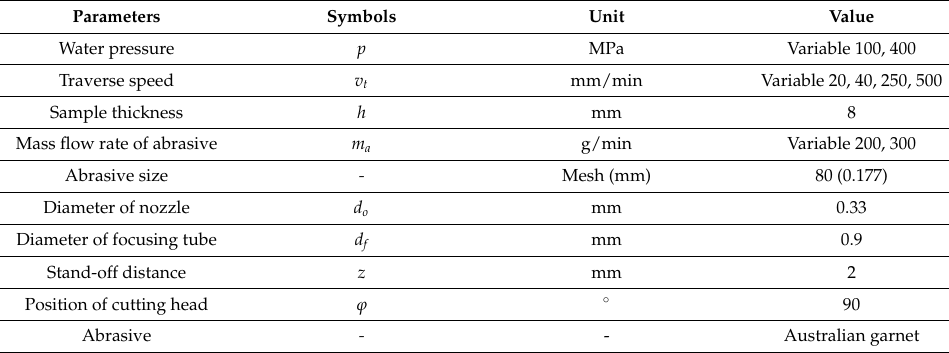
Table 2. Technological conditions of